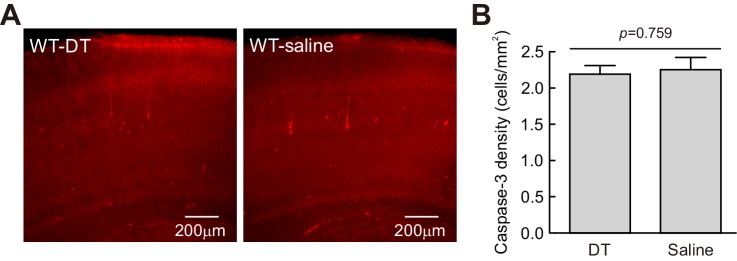
The effect of DT is specific for Cre-expressing cells.(A) Confocal microphotograph showing the cells that expressed caspase-3 in the somatosensory cortex in DT-injected CD1 mice (WT-DT, left) and saline-injected CD1 mice (WT-saline, right) at P5. (B) Comparison of the density of caspase-3 positive cells between WT-DT and WT-saline mice. Detailed statistical analysis, detailed data and exact sample numbers are presented in theFigure 6—source data 1.